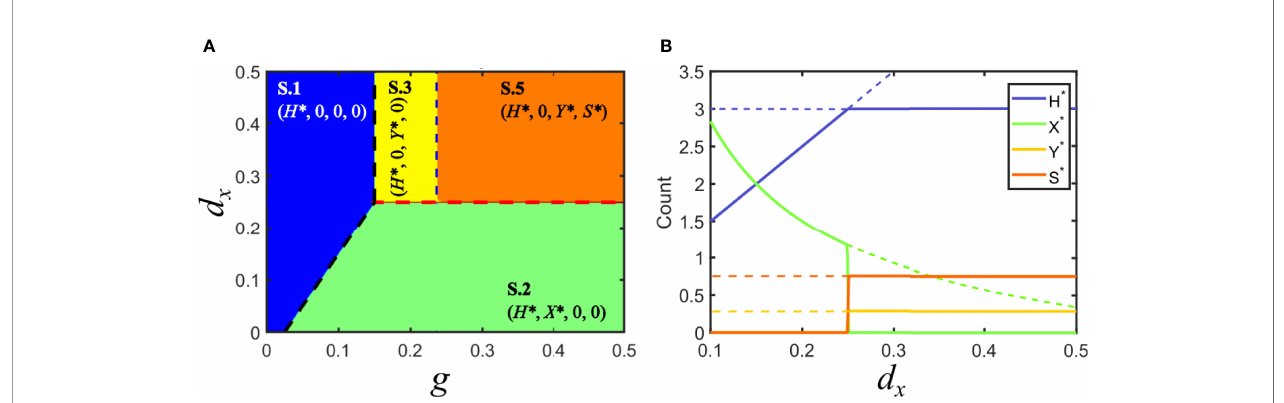
FIGURE 4 | Solutions for model S in parameter space: commensal satellite. (A) Phase space of solutions in the plane { g , d x } for a commensal satellite ( F c = F y ). The description of regions corresponding to solutions S.1 (in blue, viruses cannot infect hosts), S.2 (in green, virus x invades and virus y becomes extinct) and S.3 (in yellow, virus y invades and virus x becomes extinct) are analogous to those described for Model V. In the new orange region, the satellite stably coexists with its helper virus, S.5 . Red and black dashed lines are as in Figure 3. The blue dashed line signals the boundary separating the regions with and without co-circulating satellite. Note that the absence of virus y prevents the stable circulation of the satellite (below d x = 0.25). (B) Bifurcation diagram of a cross section of A, for g = 0.5. As above, lines stand for the amount of each class at equilibrium. Dashed lines correspond to unstable solutions, while solid lines correspond to stable solutions. Solutions collide with the degenerated solution S.4 at d = 0.05, px = 0.1, py = 0.1, dy = 0.25, ps = 0.8, psy = 0.04, ds = 0.3, p − y =